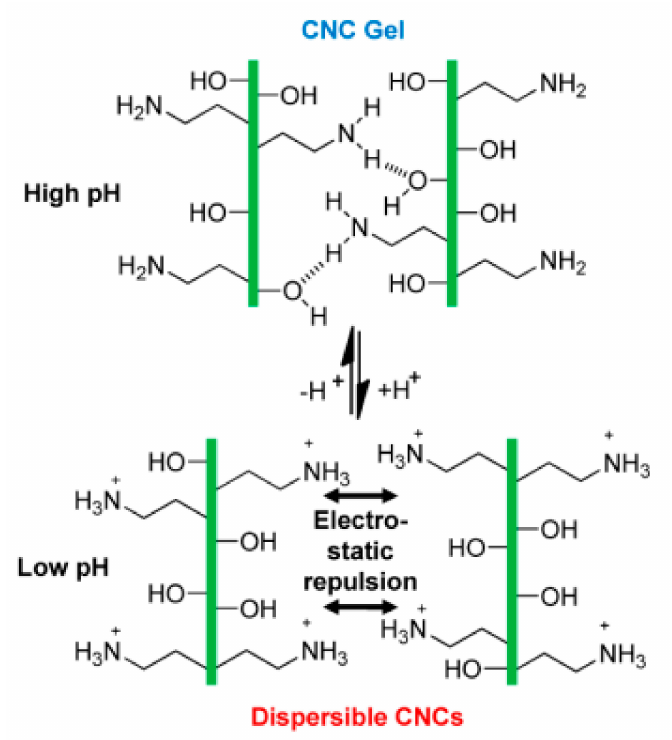
Figure 4. Schematic representation of the proposed interactions of CNC − NH 2 at high and low pH